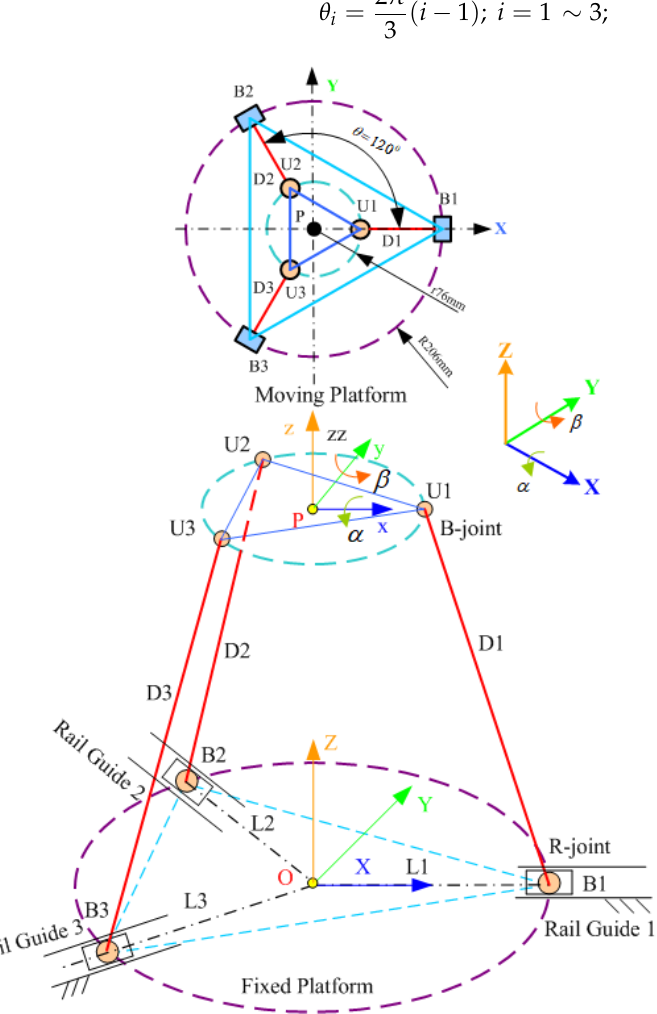
Figure 1. Horizontal parallel three-axis mechanism (3-PRS with intersecting rails).